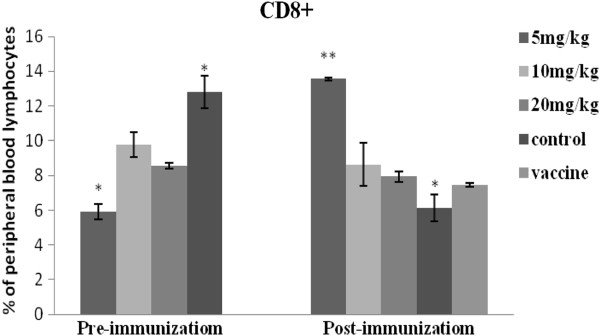
Illustrates the percentages of CD8 + T cell lymphocyte expression before and after immunization in vivo. CD8+ expression for the 5mg/kg APS group was significantly lower prior to immunization, but increased to levels higher than all the other groups post-immunization.